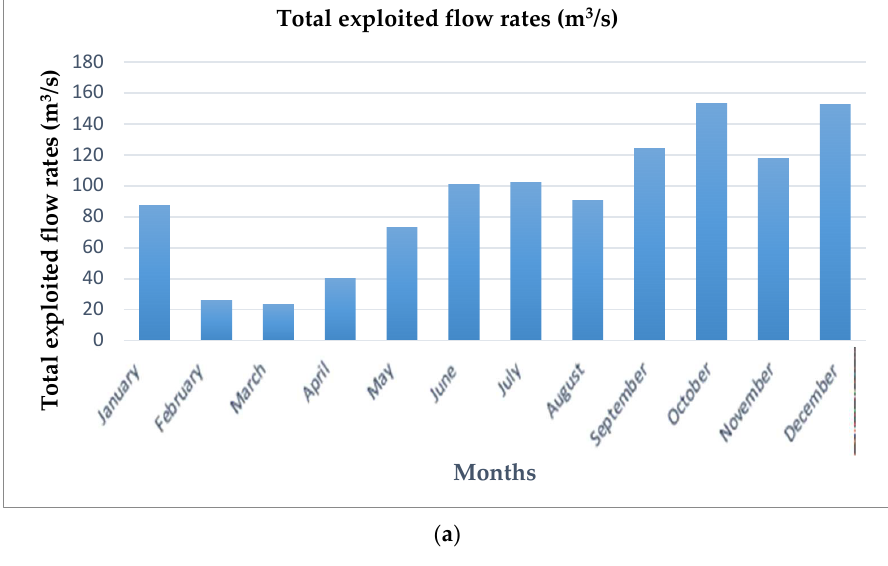
26 of 36 Figure 8. ( a ) Average monthly exploitable flow rates histogram and ( b ) average daily exploitable flow rates curve. Figure 9 shows the exploited flow rates in the plant, which is to say the flows actually used. It can be seen in Figure 9b that only during the periods of November 13 and No- vember 14 to 19 (only 7 days a year) the plant is shut down. The shutdown of the plant during these 7 days is due to the fact that the plant cannot exploit all the large flow rates in the month of November as, during these days, the daily exploitable flow rates, which are all greater than the safety flow rate (309.17 m 3 /s), is beyond which the safety of the plant is no longer guaranteed. As for the other days of the year, the plant remains in operation by efficiently using the exploitable flow rates.